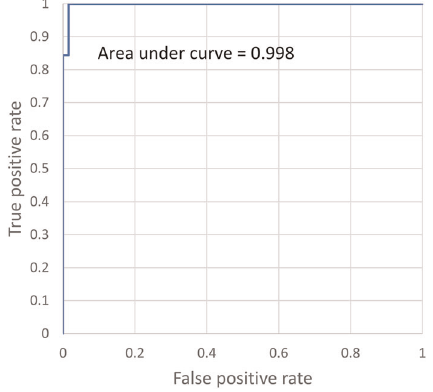
Fig. 3 ROC curve. Demonstration of the false positive rate versus the true positive rate for our sickle cell detection